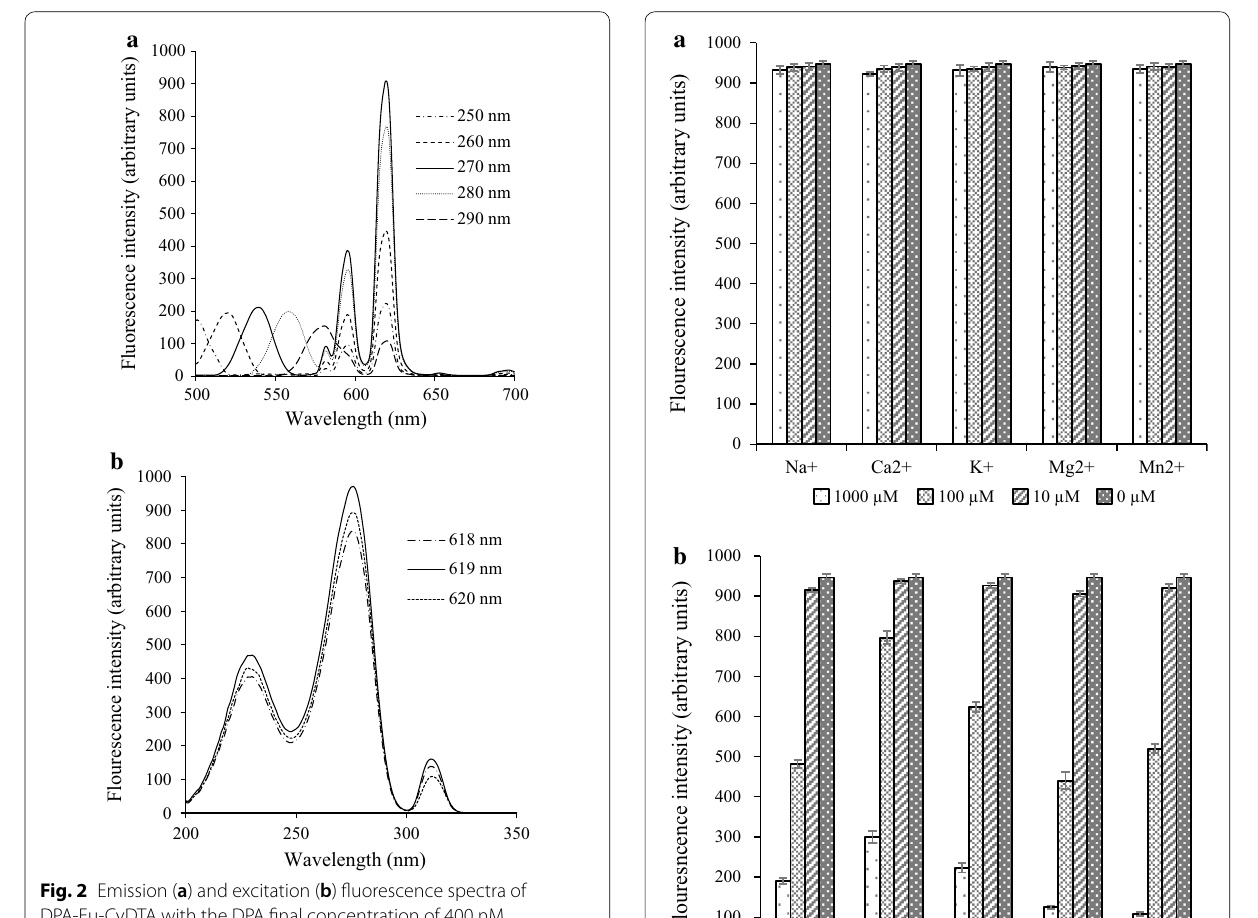
y = 2.287x - 1.1204 R² = 0.9979